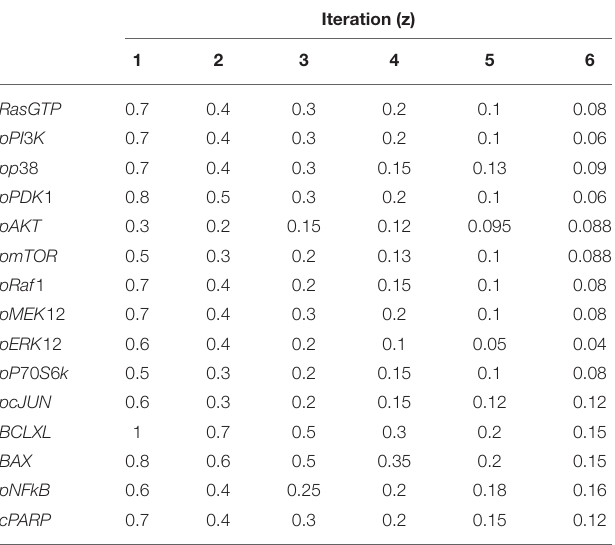
TABLE 5 | Threshold schedule of distance functions for model M3.